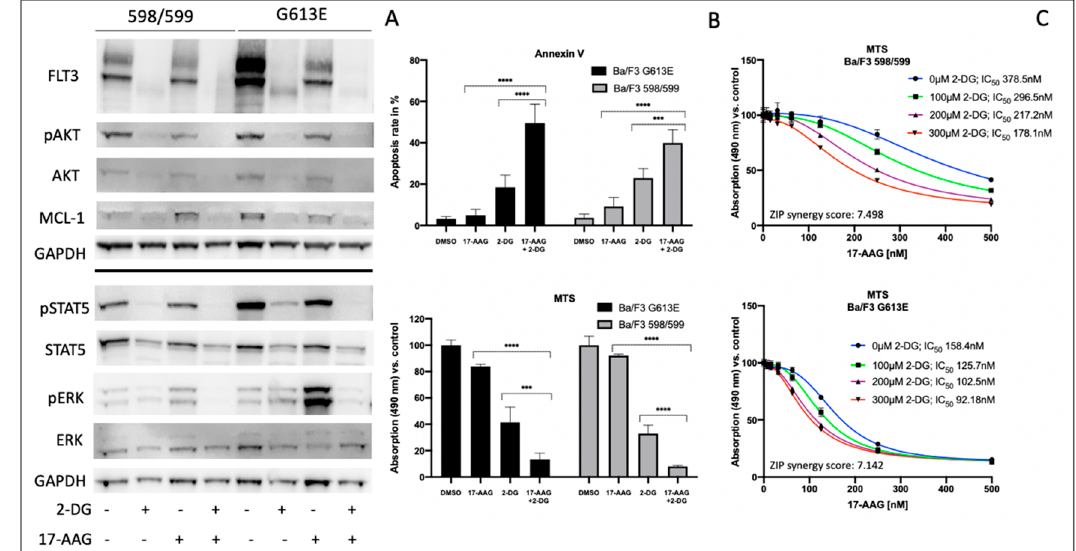
Figure 2. Impact of 2-deoxy-D-glucose on signal transduction, metabolic activity, and apoptosis of FLT3-ITD-expressing Ba/F3 cells (variant 598/599 and G613E). Ba/F3 cells stably expressing distinct FLT3-ITD were treated with 400 µ M 2-deoxy-D-glucose or 150 nM 17-AAG or sequentially as indicated. The incubation time for single compounds was 32 h for 2-deoxy-D-glucose and 24 h for 17-AAG. In the combination experiments, the cells were pre-treated with 2-deoxy-D-glucose for 8 h prior to incubation with 17-AAG for further 24 h. ( A ) cell lysates were subjected to SDS-PAGE to analyze the expression and phosphorylation status of signaling proteins. For loading control, levels of GAPDH were detected. Representative blots of three independent experiments are shown. Section ( B ) provides the corresponding data for detection of apoptosis by Annexin V staining (upper part) and metabolic activity by the MTS assay (lower part), respectively. Apoptosis is indicated by Annexin V-positive cells. The data of the MTS assay are demonstrated as relative absorption compared to untreated control. ( C ) 17-AAG concentration-dependent metabolic activity of both Ba/F3-ITD variants after 8 h pre-incubation with indicated concentrations are demonstrated. 17-AAG was added for further 24 h. IC 50 values are indicated for 17-AAG depending on different concentrations of pre-treatment with 2-deoxy-D-glucose. The calculation of potential synergy of distinct drug combinations as well as biological replicates are described in the Section 3 and illustrated in the Supplement (Figure S1). A Student’s t -test was used for calculating the statistical significance (**** p < 0.0001, *** p < 0.001, ns not